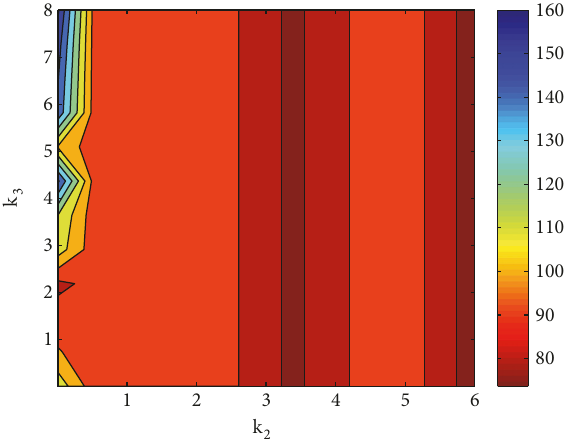
Figure 5: The distribution of the maximal power consumption of synchronous